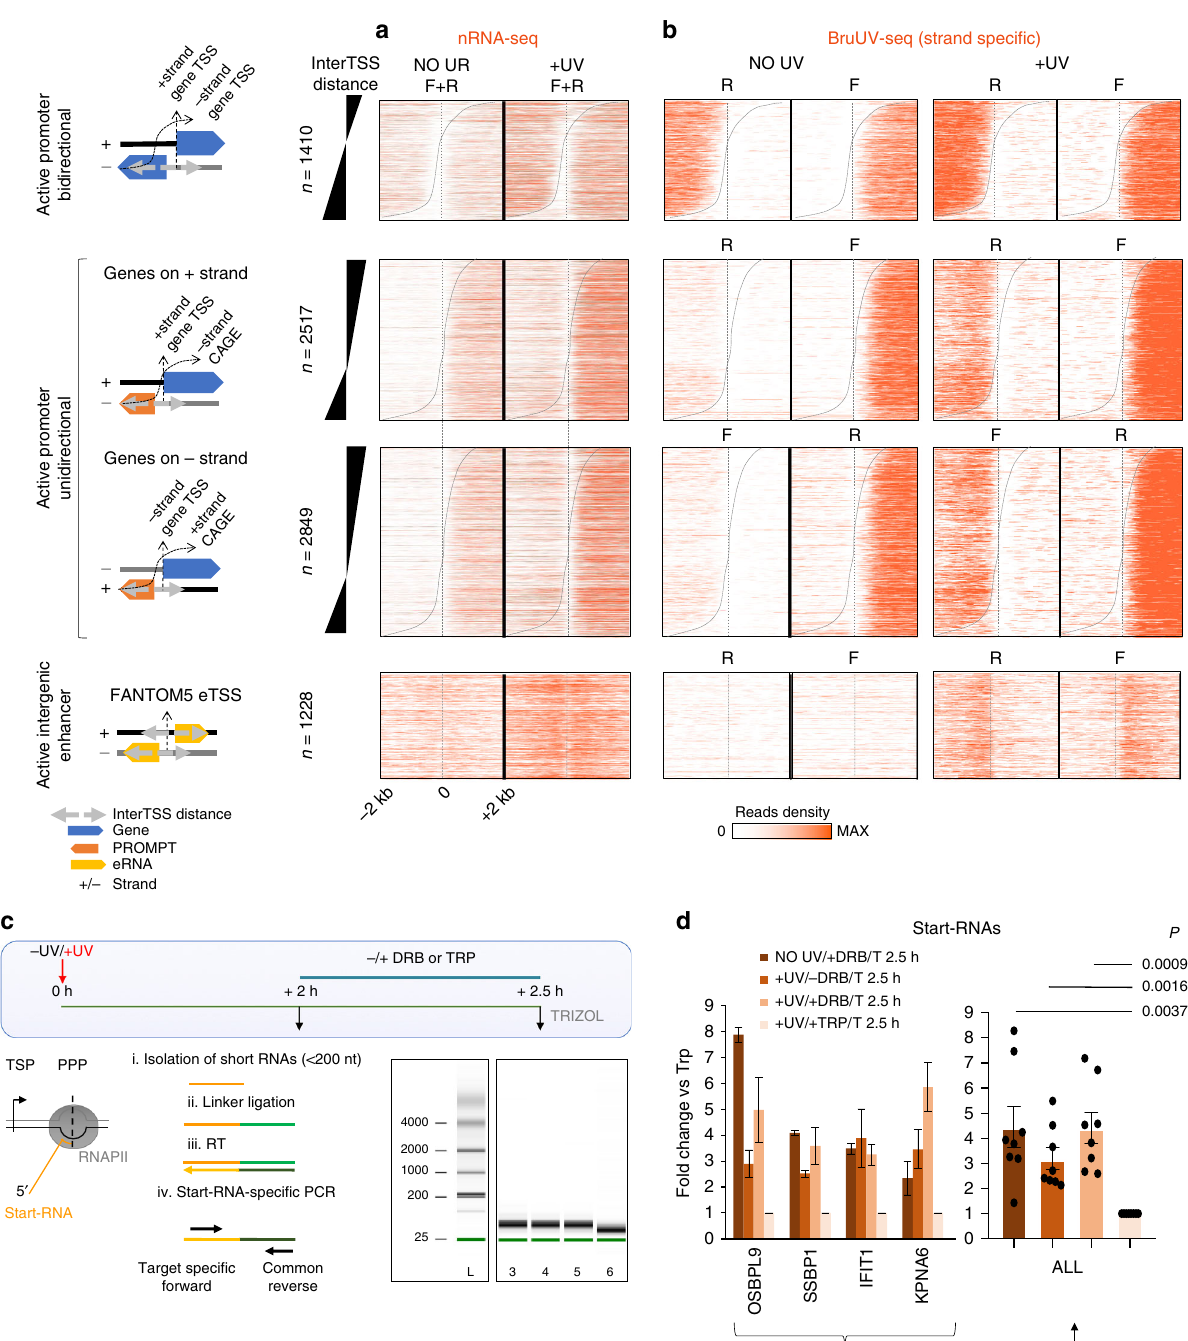
Fig. 5 De novo and increased RNA synthesis from all TSSs upon UV exposure. a . Heatmap of nascent RNA (nRNA) read densities (NO UV and + UV (60 min, 20 J/m 2 ) data obtained from ref. 25 before and after UV, in genomic regions 2 kb around TSS, for categories de fi ned in Fig. 3a – c (see “ Methods ” and Supplementary Fig. 5 for timeline). F: forward ( + ) strand, R: reverse ( − ) strand. b Same as in a for strand-speci fi c BruUV-seq (NO UV and + UV (30 min, 20 J/m 2 ) data obtained from ref. 27 ). c (Upper panel) Experimental outline. Cells were treated (or not) with UV, and were left to recover normally for 2 h. In turn, DRB, TRP, or DMSO was added, and after 30 min, cells were disrupted by Trizol addition. (Lower panel, left) Methodology followed for the detection and quanti fi cation of gene-speci fi c start-RNAs (for details see “ Methods ” ). (Lower right) Agilent RNA 6000 Nano Bioanalyzer traces showing size distribution of RNA samples after preparation of a separate small-sized RNA fraction. L: RNA ladder (size in nucleotides), 3 – 6: small-sized RNA fraction of samples analyzed in d . d qPCR analysis of start-RNAs. Bar chart illustrating FC (compared with TRP treatment), for each gene tested (left) and for the average FC of all genes (right). Error bars represent S.E.M., and P values are calculated using two-sided Student ’ s t